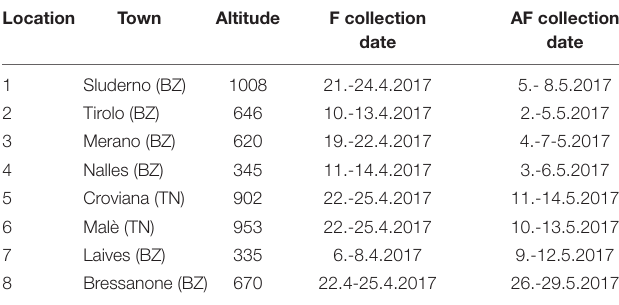
TABLE 1 | Sample collection